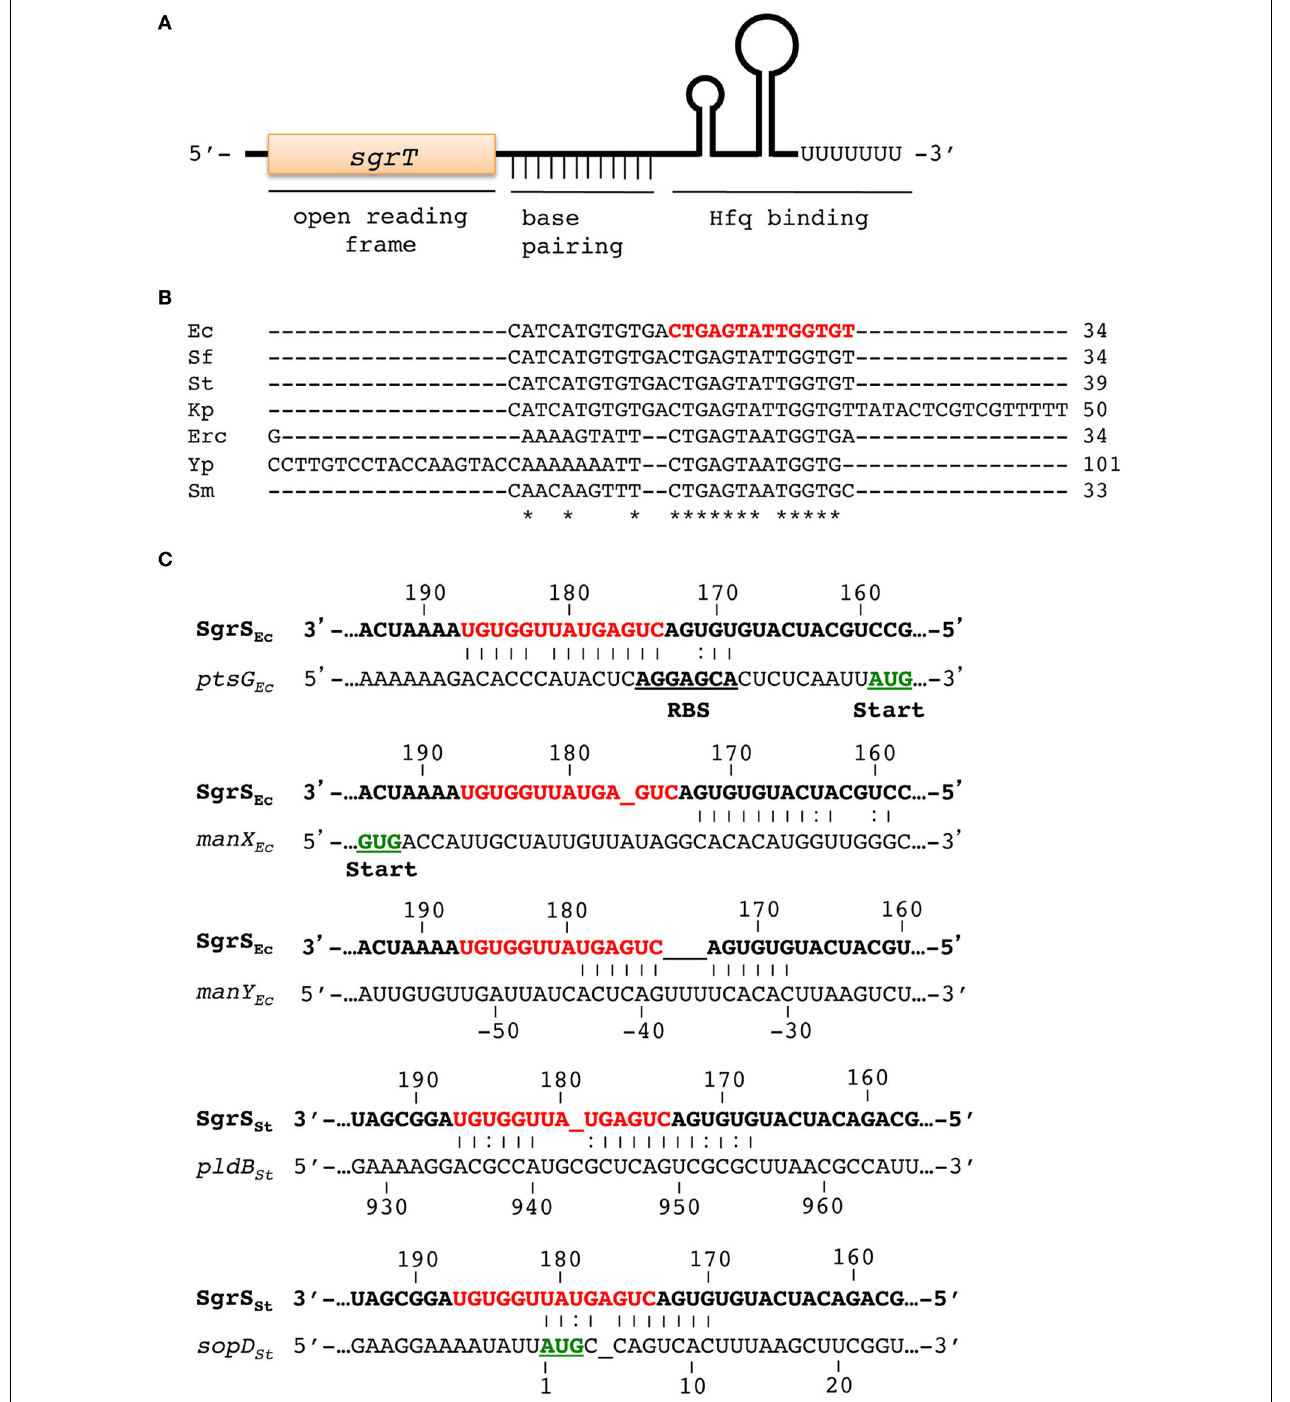
FIGURE 2 | Characteristics of SgrS and SgrS-mRNA base pairing interactions. (A) The main functional domains of SgrS are illustrated. The sgrT open reading frame is located at the 5 (cid:2) end, the conserved base pairing region is downstream of sgrT and upstream of the intrinsic terminator hairpin (which comprises the Hfq-binding domain). (B) Alignment of the base pairing region of SgrS homologs from enteric species. The most conserved region is indicated by asterisks below the alignment and in red for the E. coli (Ec) homolog. Abbreviations for other species: Sf, Shigella flexneri ; St, Salmonella